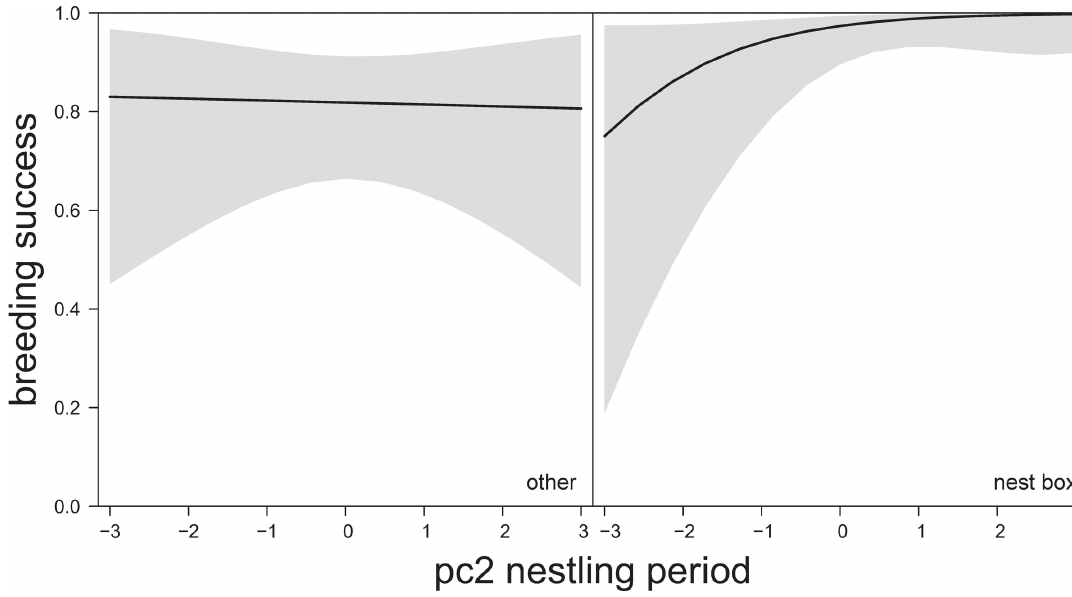
Fig 6. The relationship between breeding success and temperature and rainfall pc2 (estimate 0.86 ± 0.49 SE, χ 2(n = 159) = 3.07, P = 0.080) [negative values: Low average, min and max temperatures and high precipitation (total sum of rain, number of rain days and rain intensity); positive values: High temperatures and low precipitation]; during the nestling period in the urban subset (including only nests with > 40% urban cover) based on predicted values of Hurdle model (binary part), 95% CIs in shaded grey. Model details in Table